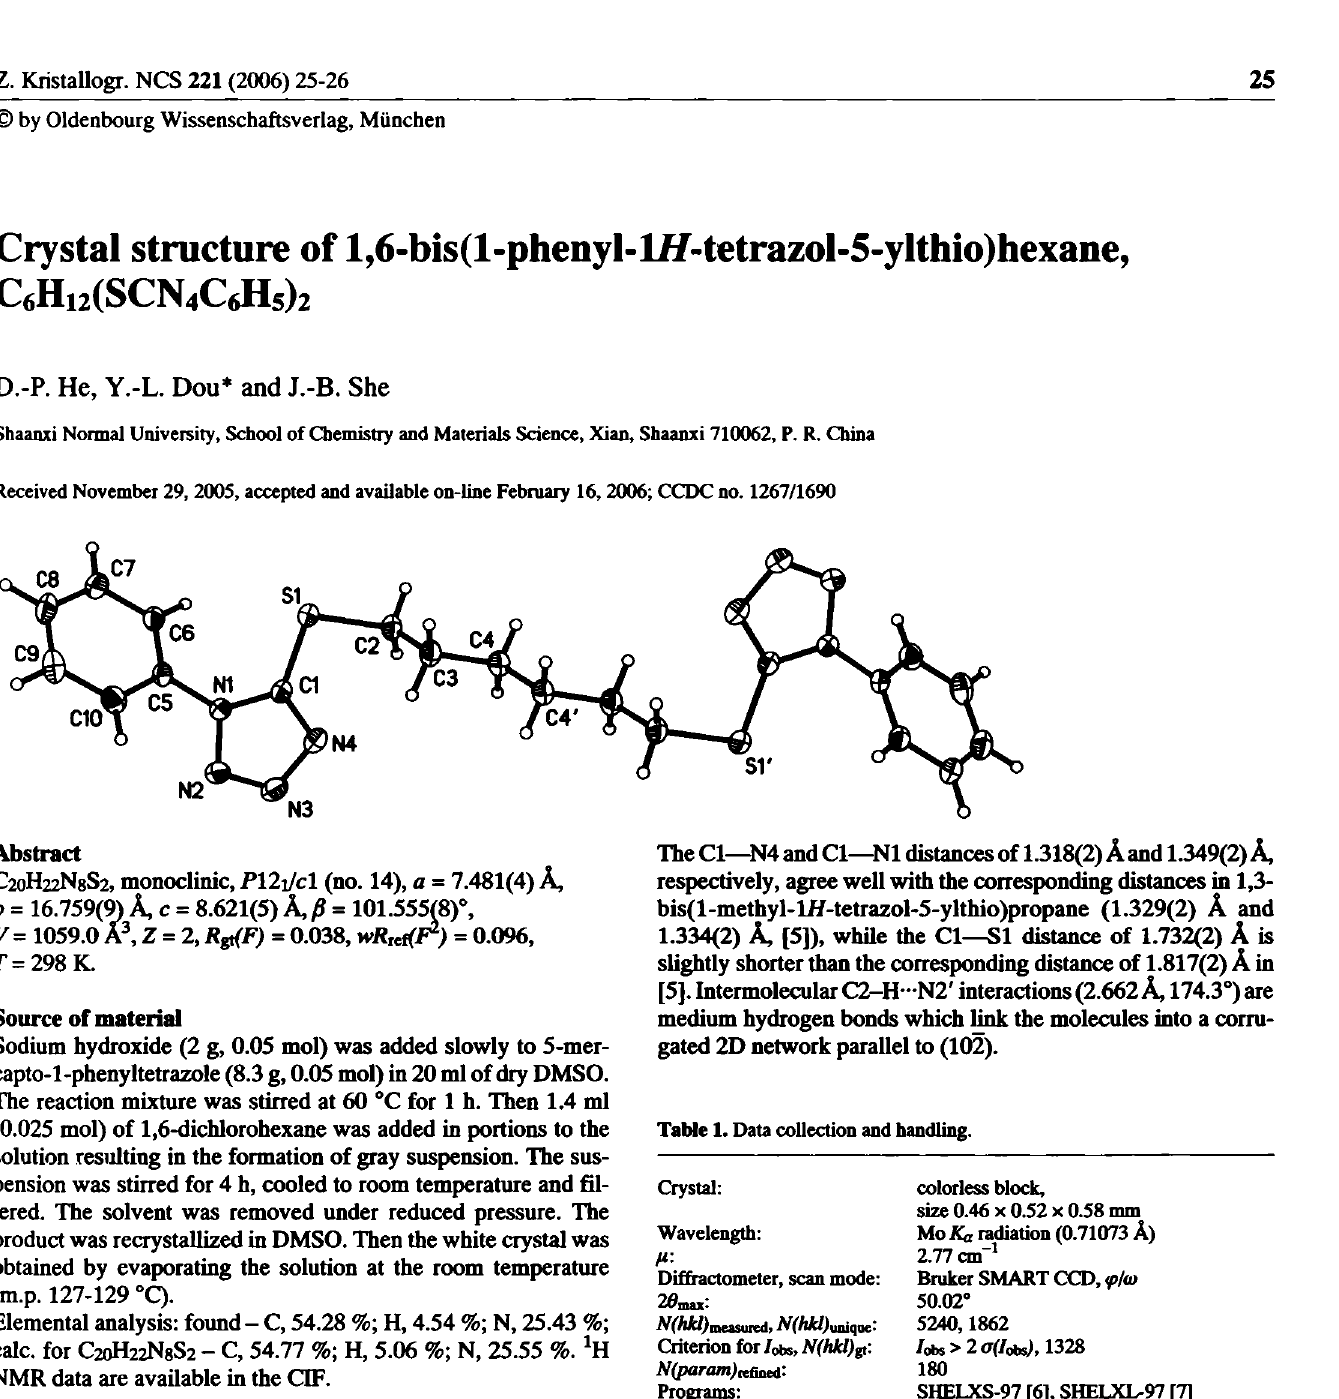
Table 2. Atomic coordinates and displacement parameters (in A 2